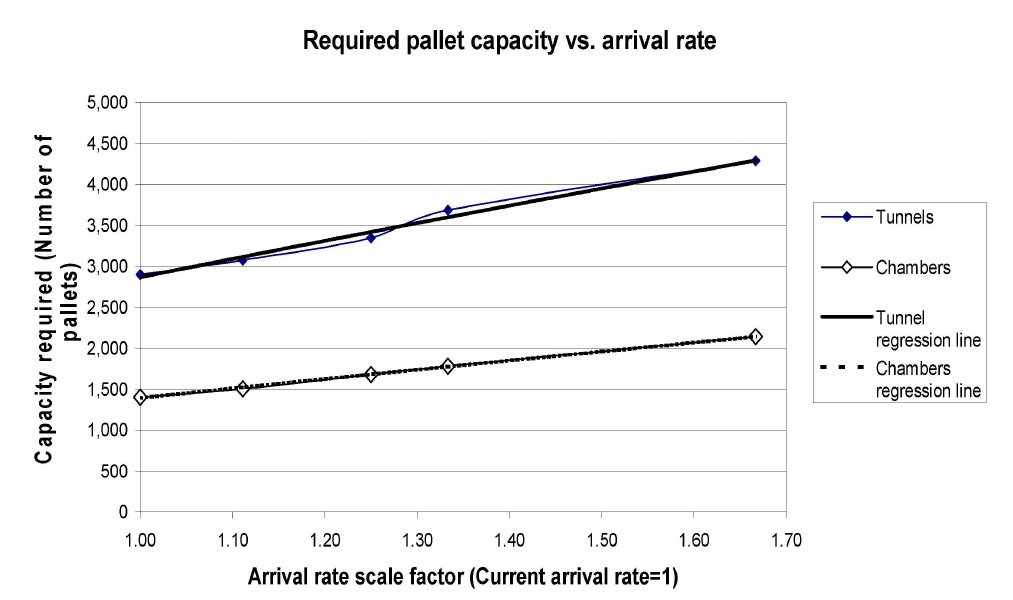
Figure 6: Required capacities as functions of arrival